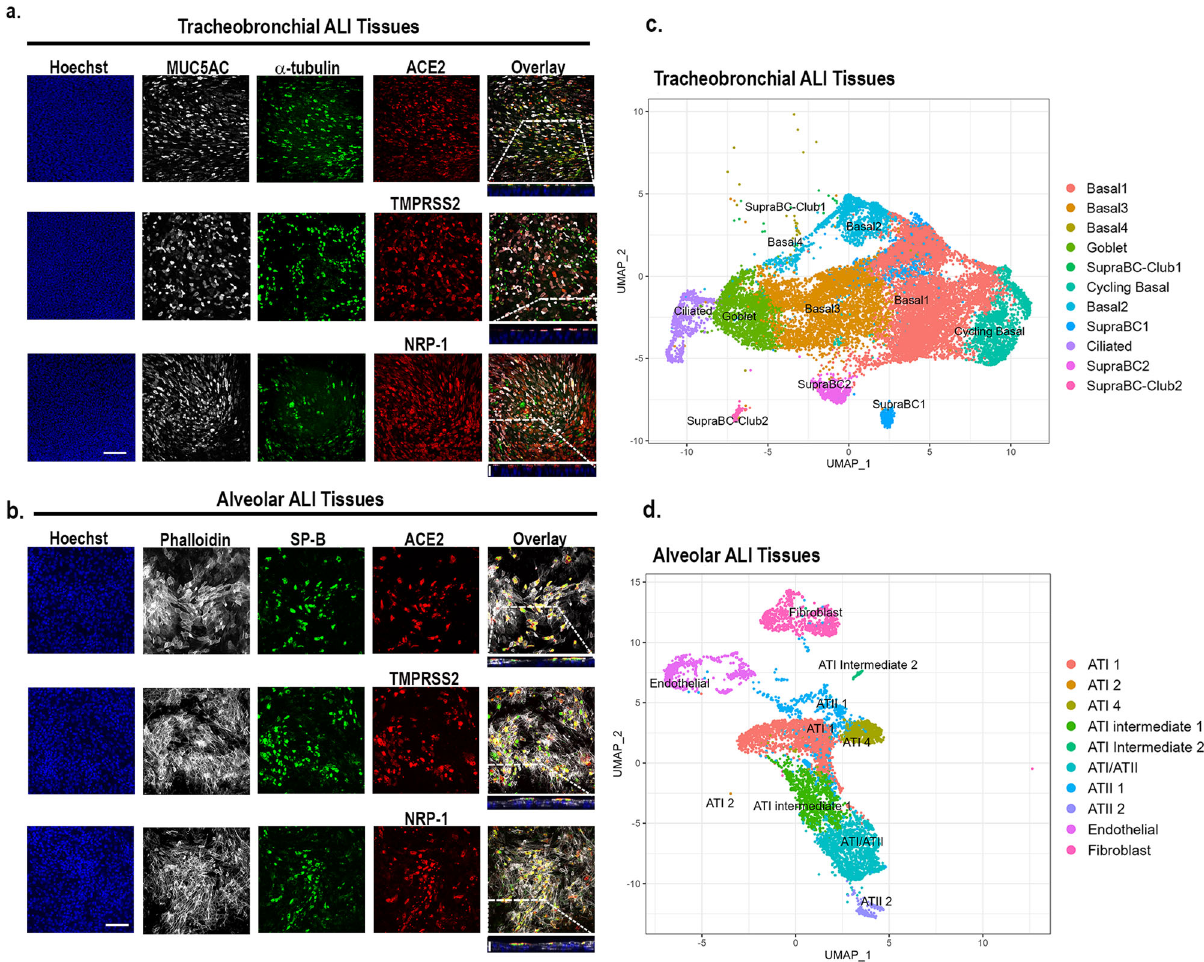
Fig. 1 Apical expression patterns of known SARS-CoV-2 entry co-factors in tracheobronchial and alveolar ALI tissue equivalents. Post-day 21 tissues were stained with antibodies targeting ACE2, TMPRSS2, and NRP-1, as well as tissue-speci fi c markers. a Representative stained images of tracheobronchial ALI tissues with Hoechst (nuclei marker, blue), MUC5AC (goblet cell marker, white) α -tubulin (ciliated cell marker, green), and ACE2 (top panel, red), TMPRSS2 (middle panel, red) or NRP-1 (bottom panel, red). The overlay image represents the maximum intensity projection of stained markers. The y/z plane cross section taken from the highlighted portion shows the selective apical expression of ACE2, TMPRSS2, and NRP-1. b Representative stained images of alveolar ALI tissues with Hoechst (nuclei marker, blue), phalloidin (f-actin, white), surfactant protein B (SP-B, ATII/pneumonocyte type II cell marker, green) and co-stained with ACE2 (top panel, red), TMPRSS2 (middle panel, red) or NRP-1 (bottom panel, red). The overlay image represents the maximum intensity projection of stained markers and a y/z plane cross section from the highlighted portion shows the selective apical expression of hACE2, TMPRSS2, or NRP-1 in the tissues, contrasted to phalloidin, which is present throughout the tissue cross-section. Scale bar is 100 μ m. Cross- section scale bar is 20 μ m. Uniform Manifold Approximation and Projection plots (UMAP plots) of scRNAseq data of dissociated ( c ) tracheobronchial or ( d ) alveolar ALI